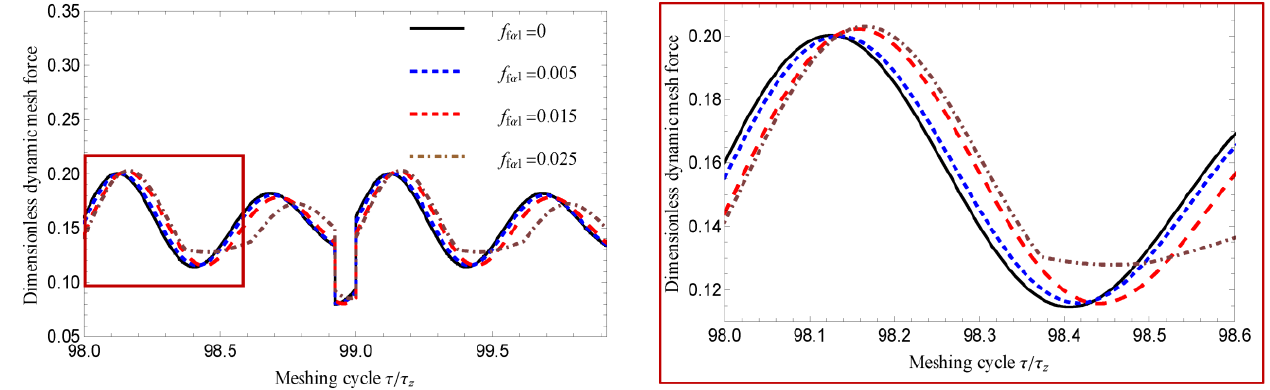
Figure 11. Total dynamic mesh force under different 𝑓 𝑓𝛼1 .